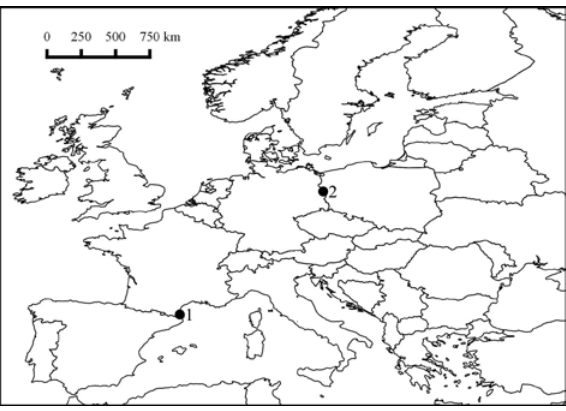
Fig. 1. location of the study areas: 1 – la Jonquera (els límits) – le perthus on the spanish-French borderland, 2 – Słubice – Frankfurt-am-Oder on the polish-German borderland. source: authors’